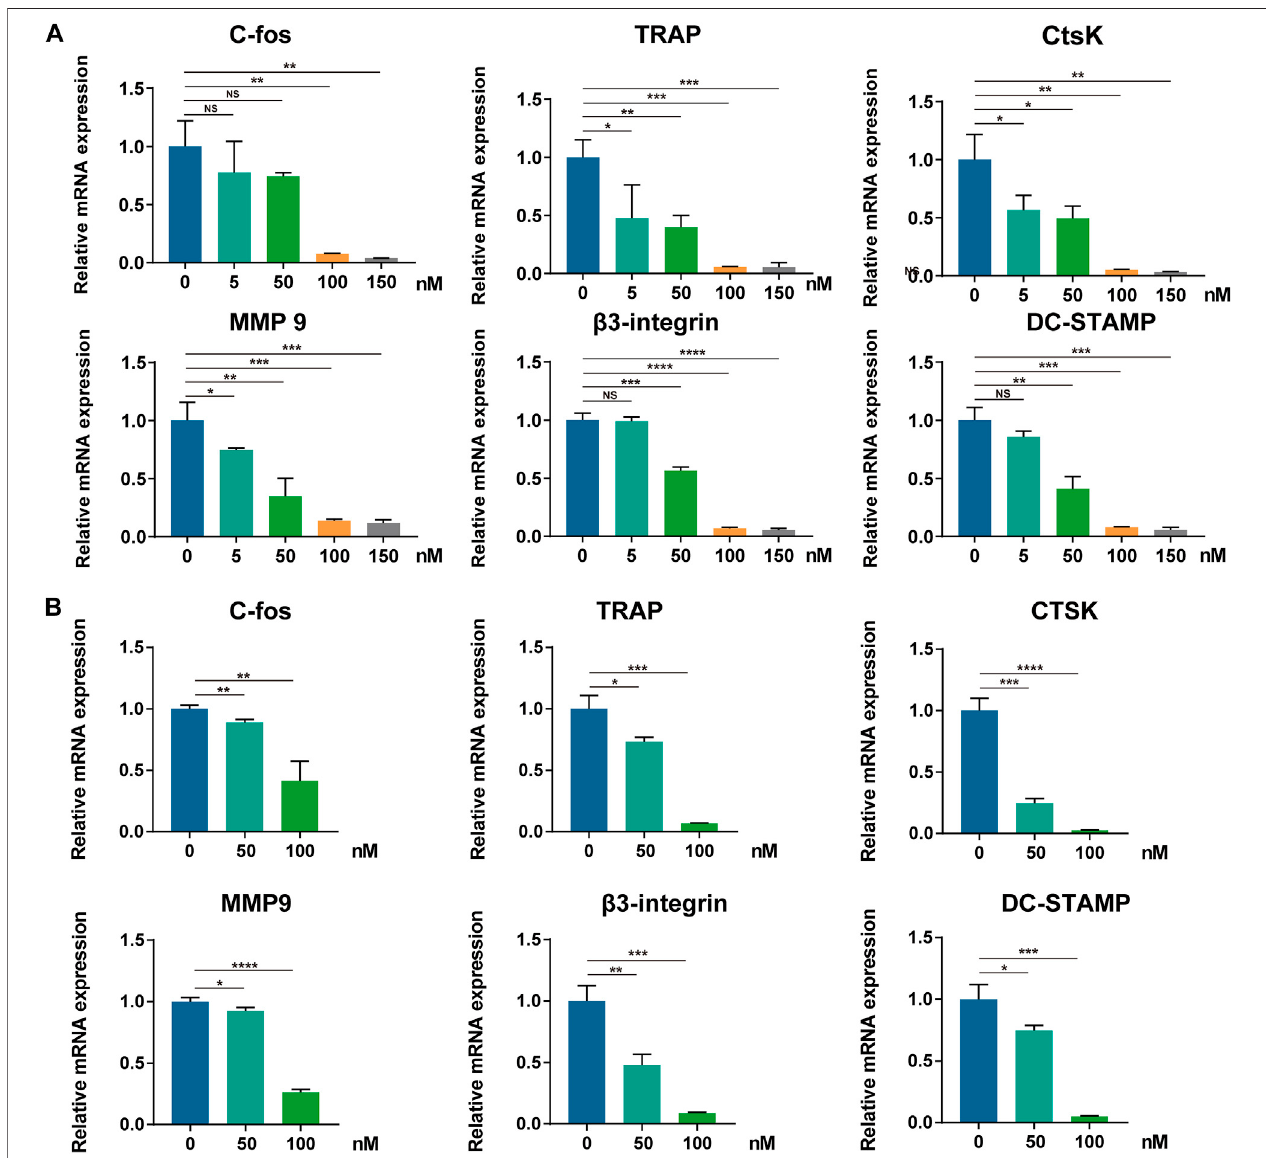
FIGURE4| CS-6suppressesRANKL-mediatedmarkergenesexpressioninosteoclastogenesis. (A,B) TherelativemRNAexpressionofOC-relatedgenes(c-Fos, TRAP, CTSK, MMP-9, DC-STAMP, and β 3-integrin) following CS-6 treatment was measured by qRT-PCR in the early (A) and late (B) stages of stimulation. Values presented as the mean ± standard deviation. * p < 0.05, ** p < 0.01, *** p < 0.001, **** p < 0.0001.